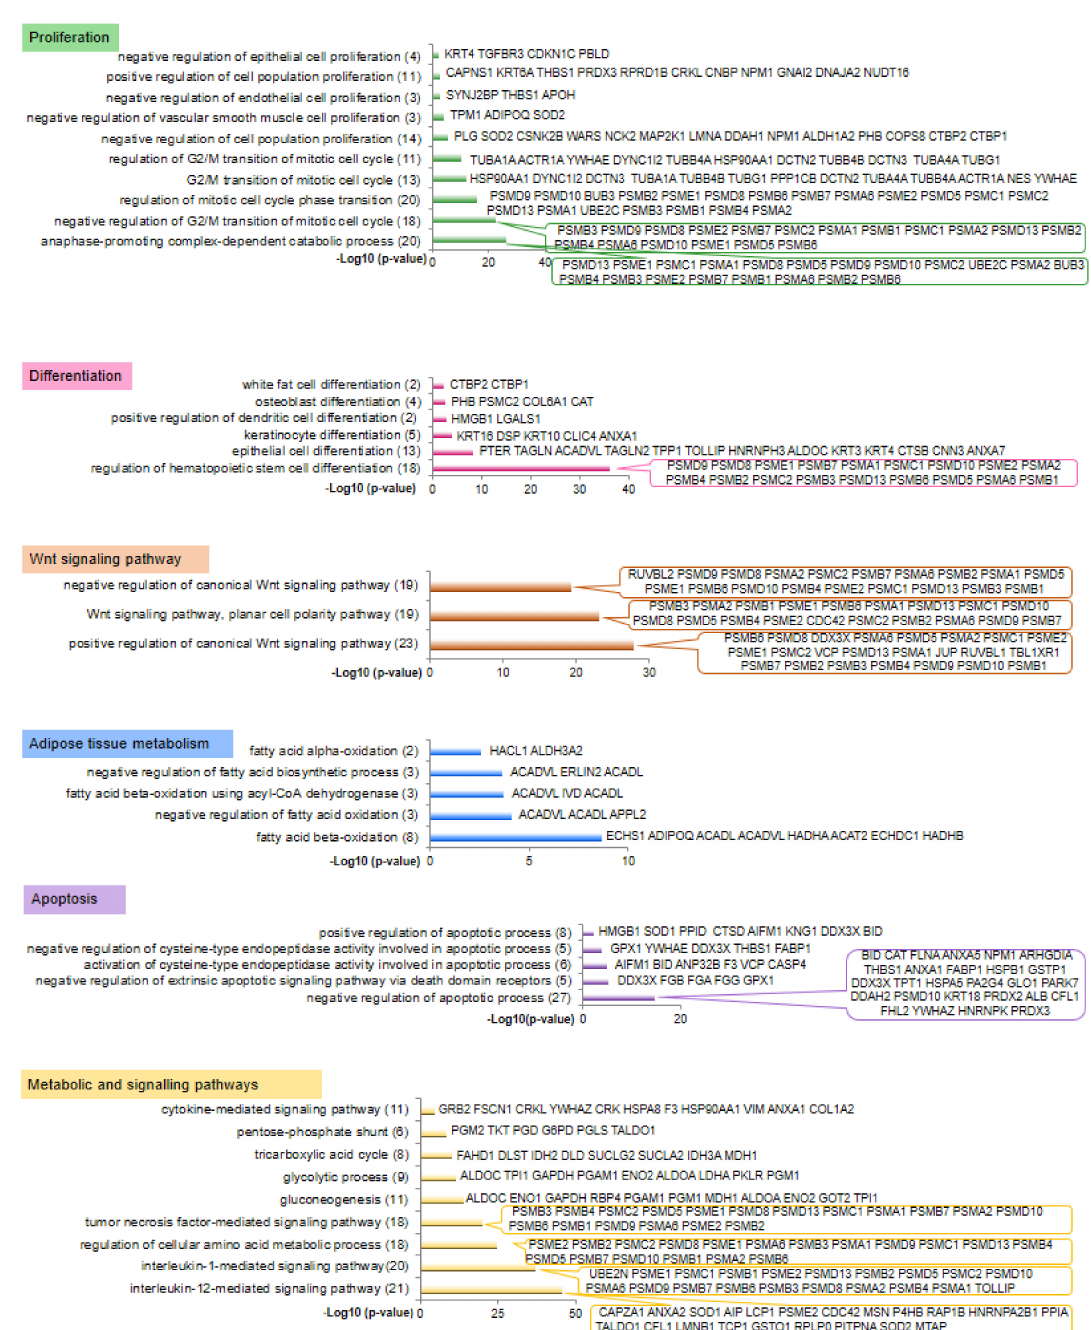
Figure 2. A focus on the most significantly GO terms that have annotated proteins identified in fetal adipose tissue (both perirenal and omental adipose tissues) at 140 days post-conception. GO terms were grouped according to major biological functions. Results were obtained with ProteINSIDE and enrichments are expressed as − log 10 ( p -value) to visualized on graphs, which means that log 10 values ( p -value) of 3, 2, and 1.3 correspond to p -values of 0.001, 0.01, and 0.05, respectively. The total number of proteins annotated by GO terms is shown in